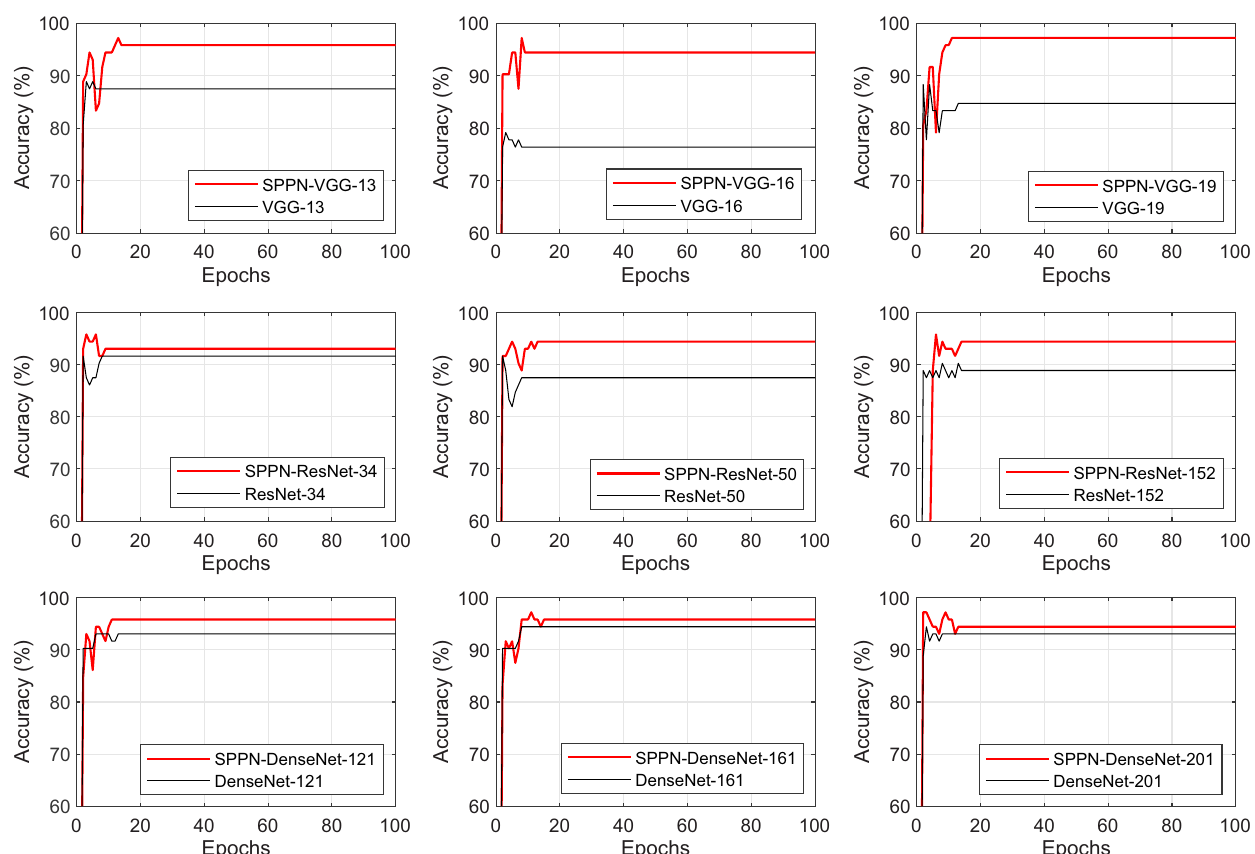
Figure 5. Convergence of Semi-ProtoPNet compared with different